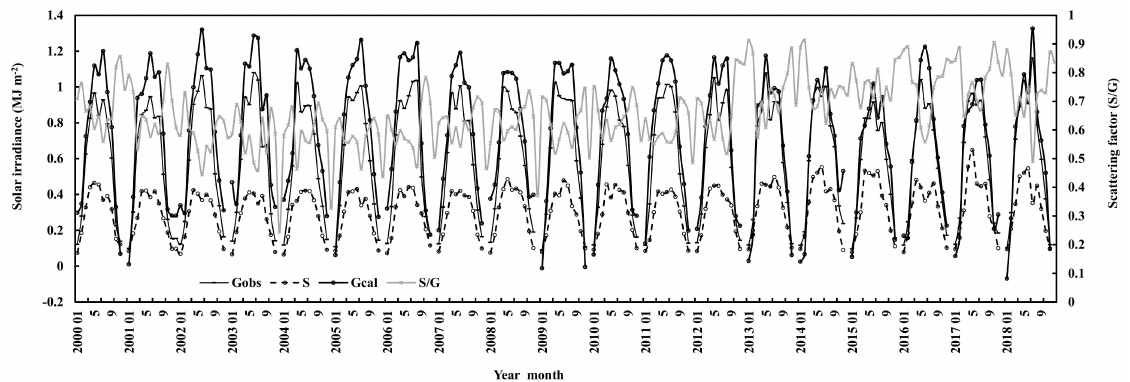
Figure 5. Monthly global solar irradiance calculated and observed (G), observed diffuse irradiance (S) and scattering factor (S/G) at